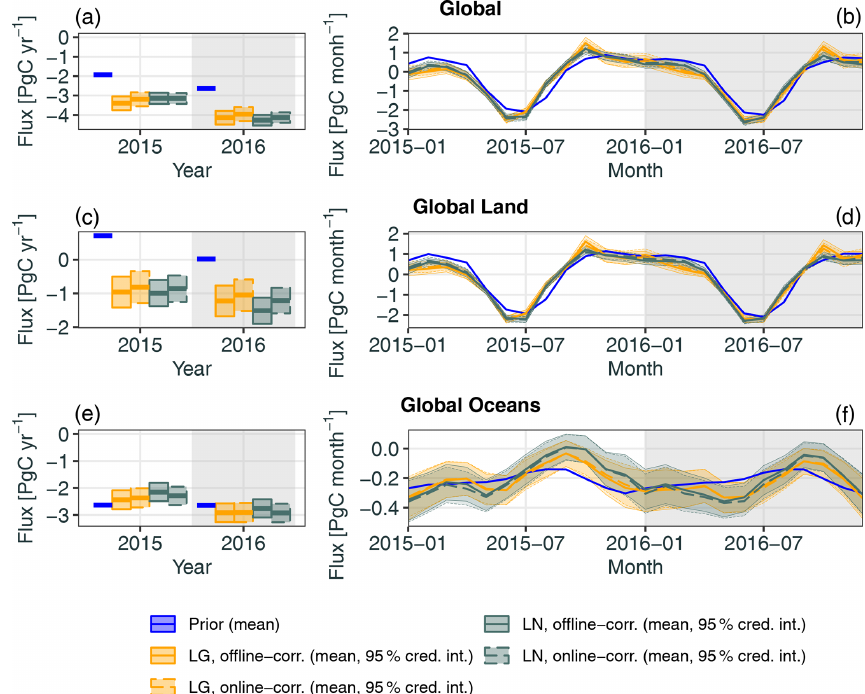
Figure 8. Annual and monthly fluxes for WOMBAT inversions using TCCON-based offline bias-corrected retrievals (solid yellow lines for LG and dark green lines for LN; the fluxes are the same as in Figs. 4 and S4, respectively) and with online bias correction applied to the uncorrected retrievals (dashed lines). The prior-mean fluxes are shown in blue. Solid lines depict prior and posterior means, and shaded areas denote the 95% credible intervals (cred. int.). Panels (a, b) depict global fluxes, (c, d) global land fluxes, and (e, f) global ocean